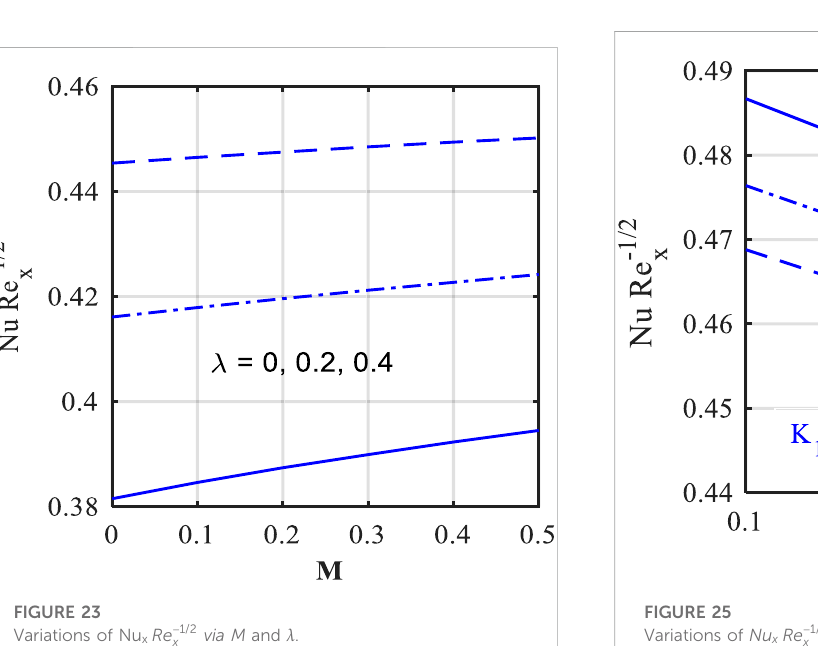
FIGURE 25 Variations of Nu x Re − 1/2 x via K 1 , K 2 , and β